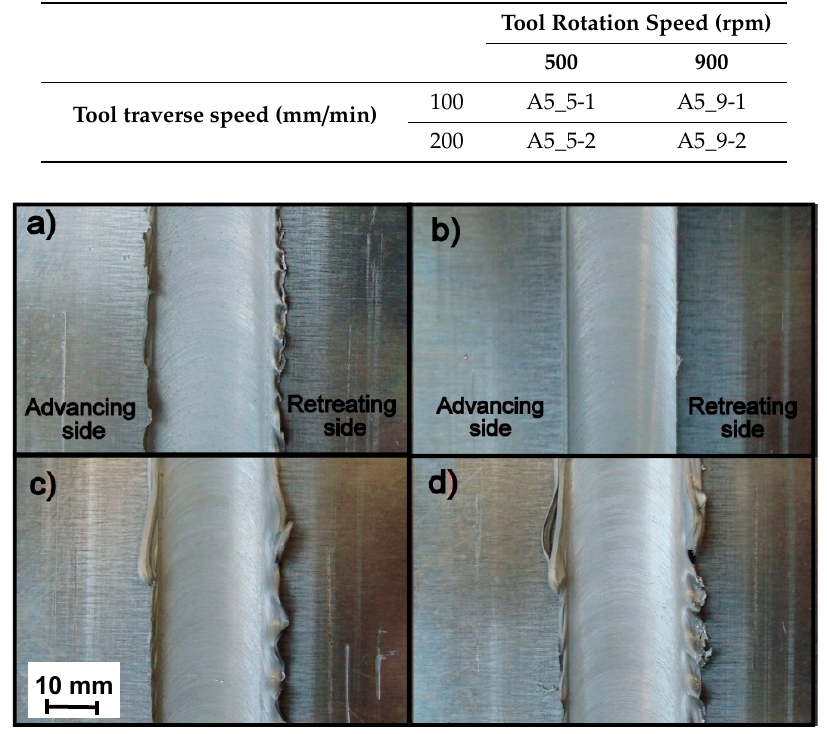
Figure 1. Surface morphologies of friction stir welded (FSW) joints from the face side with different connection process parameters: ( a ) A5_5-1, ( b ) A5_5-2, ( c ) A5_9-1, and ( d ) A5_9-2.